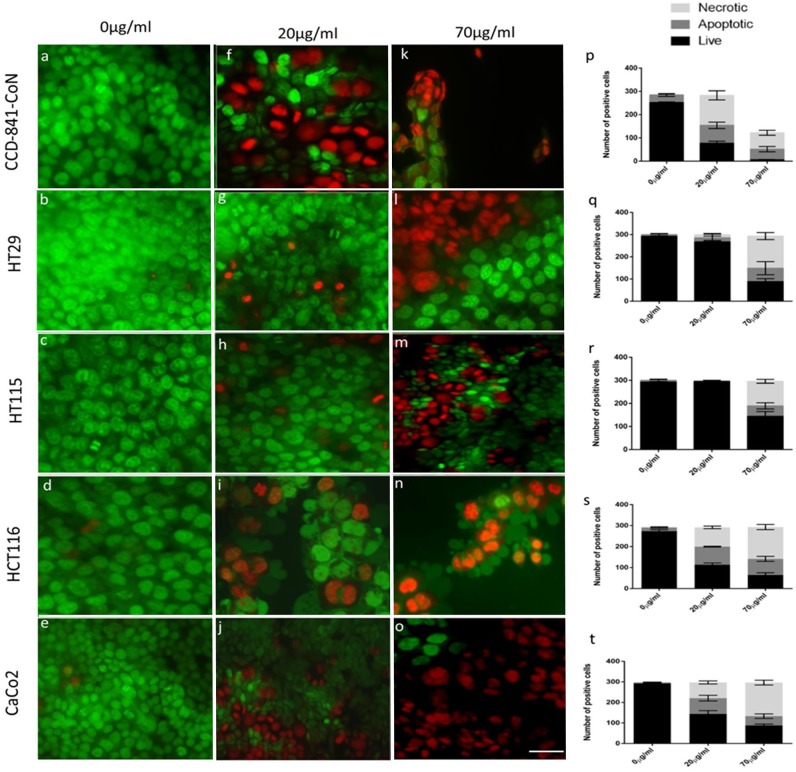
LSL induced both necrosis and apoptosis in vitro.Photomicrographs of acridine orange and ethidium bromide stained cultures following treatments with 0 (a-e), 20 (f-j) or 70μg/ml (k-o) LSL and quantification of live, apoptotic or necrotic cells (p-t). The vast number of CCD-841-CoN (a) and cancer cells treated with vehicle control are morphologically viable with a small number showing condensed nuclei (apoptotic). 20μg/ml LSL resulted in necrosis (red/orange clusters) in all cell lines, although CCD-841-CoN (k.p ****p<0.0001) and Caco2 cells (j.o ** p<0.001) were more susceptible. At 70μg/ml, very few adherent CCD-841-CoN cells were observed (k), remaining adhered cells were either necrotic or apoptotic (p). HT29 (l), HT115 (m), HCT116 (n) and Caco2 (o) cells exposed to 70μg/ml LSL all had 50% of cells with morphological features of cells death (q-t) and statistically significant increases in either the numbers of necrotic (*** p<0.0001) or apoptotic cells (**p<0.001) as compared with vehicle only controls.